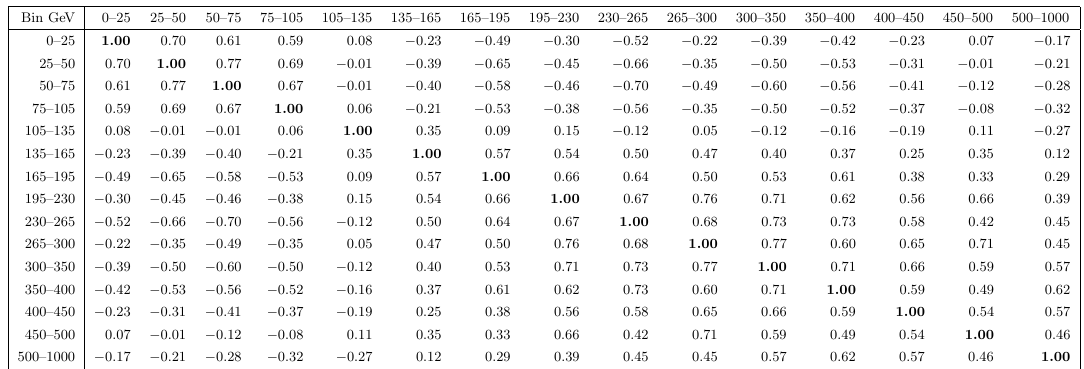
Table 4. Correlation matrix of the relative cross-section as a function of the hadronic top-quark p T , accounting for the statistical and systematic uncertainties in the resolved topology.